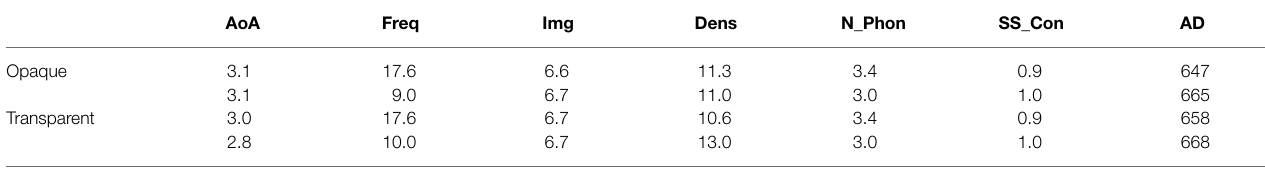
TABLE 1 | Psycholinguistic variables for the opaque and transparent words (within each condition, means are shown on top and medians on the bottom). AoA Freq Img Dens N_Phon SS_Con